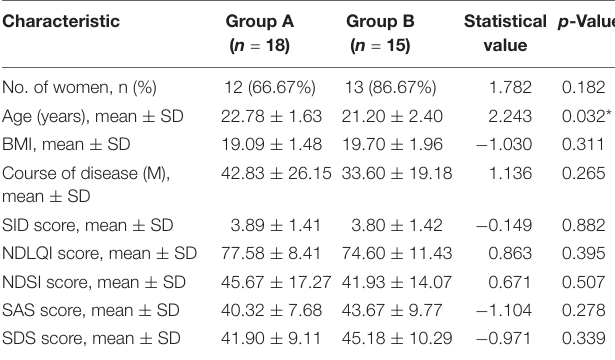
TABLE 1 | The baseline characteristics in two